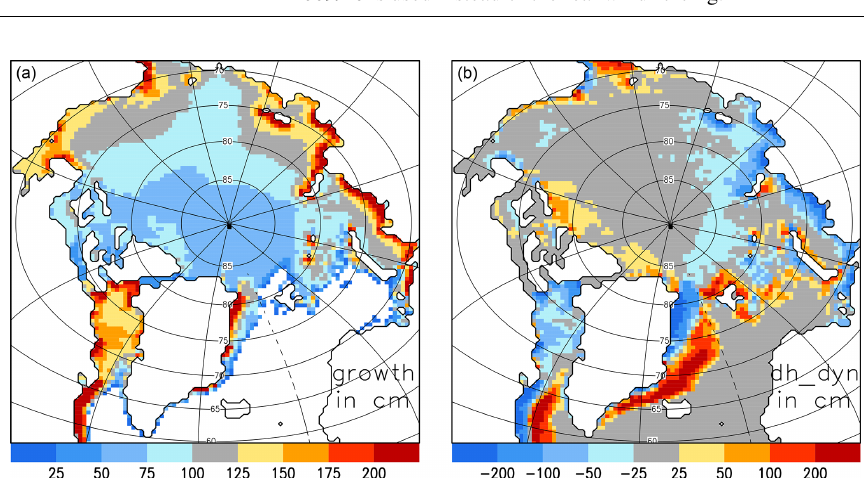
Figure 2. Mean simulated sea ice thickness change from November to April (2010–2016) in CICE-default: (a) sea ice growth in centimetres and (b) sea ice thickness change by dynamical processes dh_dyn in centimetres (advection, convergence, and